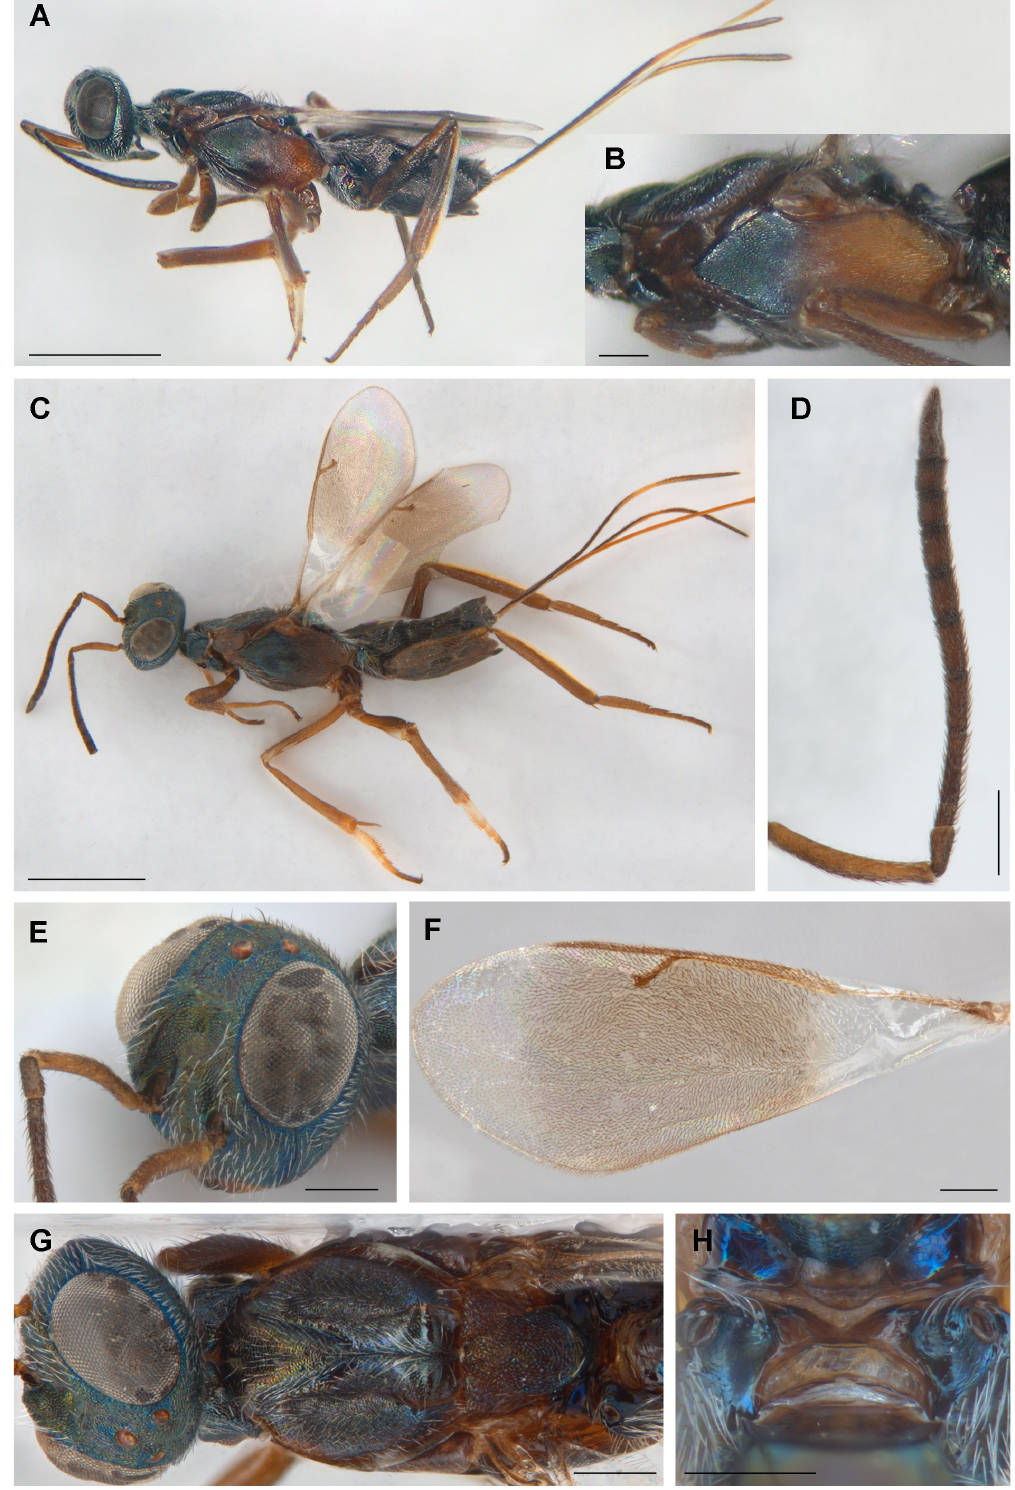
Fig. 1. Female of Tineobius ( Tineobius ) tamaricis Ribes & Fusu sp. nov. A . Habitus of holotype before card mounting. B . Mesosoma (paratype 13940). C – G . Paratype 10077. C . Habitus. D . Antenna. E . Head. F . Fore wing. G . Head and mesosoma, dorsal view. H . Metanotum and propodeum (paratype 13940). Scale bars: A, C = 1 mm; B, D–H = 0.2